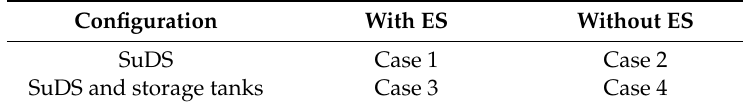
Table 1. Combination of drainage configurations with and without ES benefits for